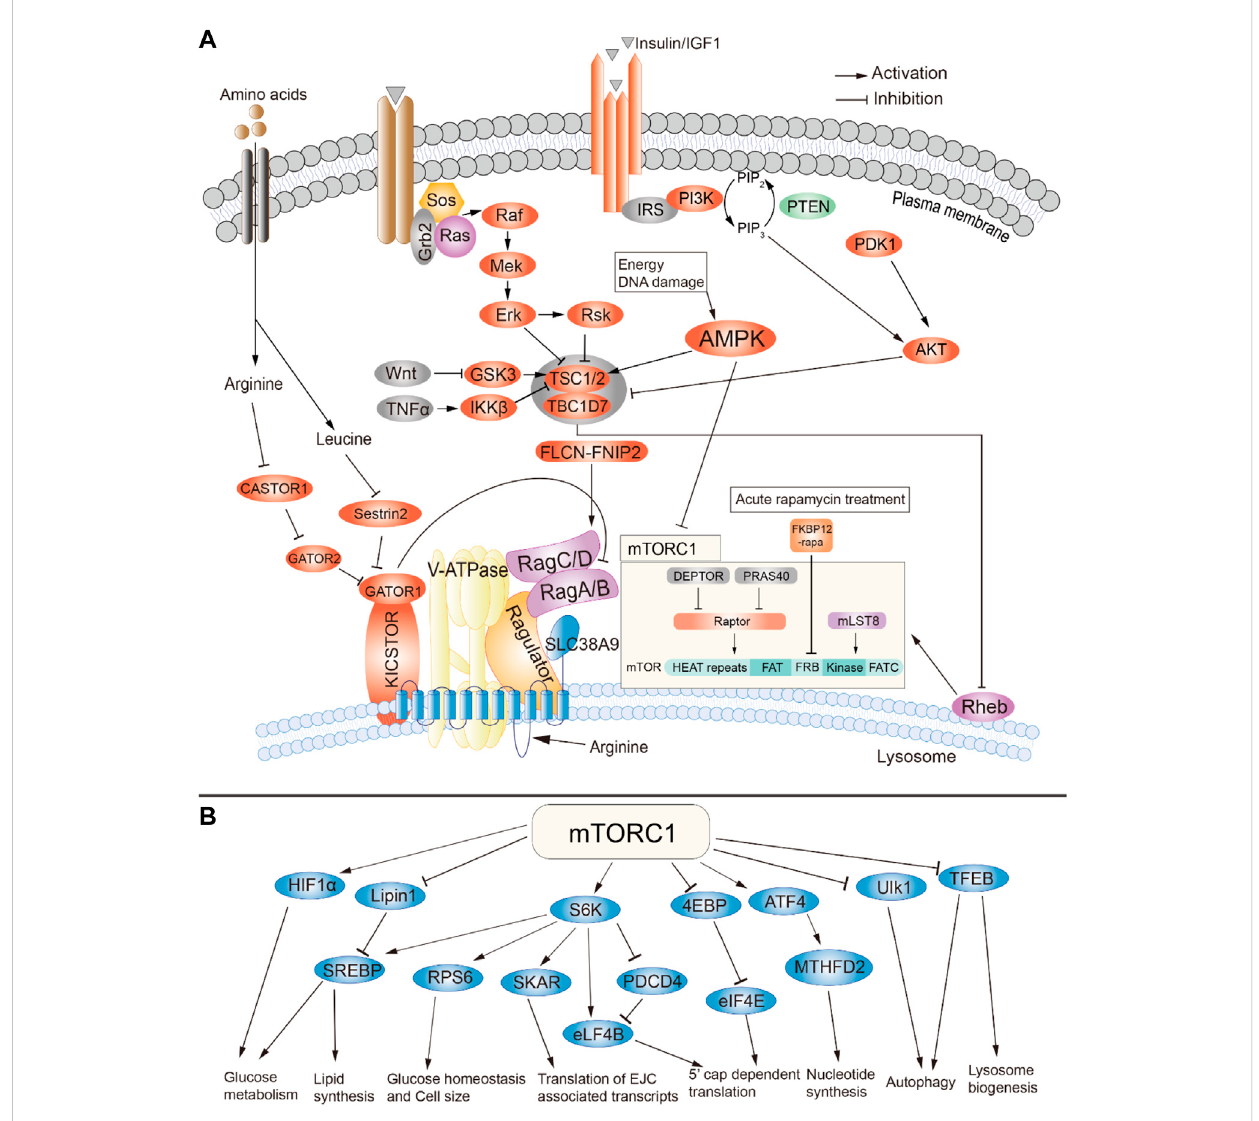
FIGURE 1 Summary of signaling through mTOR complex 1. (A) Activators of mTORC1. (B) Downstream targets and cellular effects of mTORC1. Adapted from (Wei et al., 2019), available through an CC BY license http://creativecommons.org/licenses/by/4.0/.